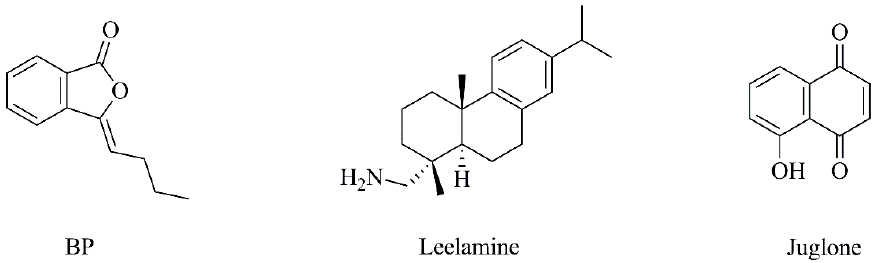
Figure 15. Chemical structures of n -butylidenephthalide (BP), leelamine and juglone.